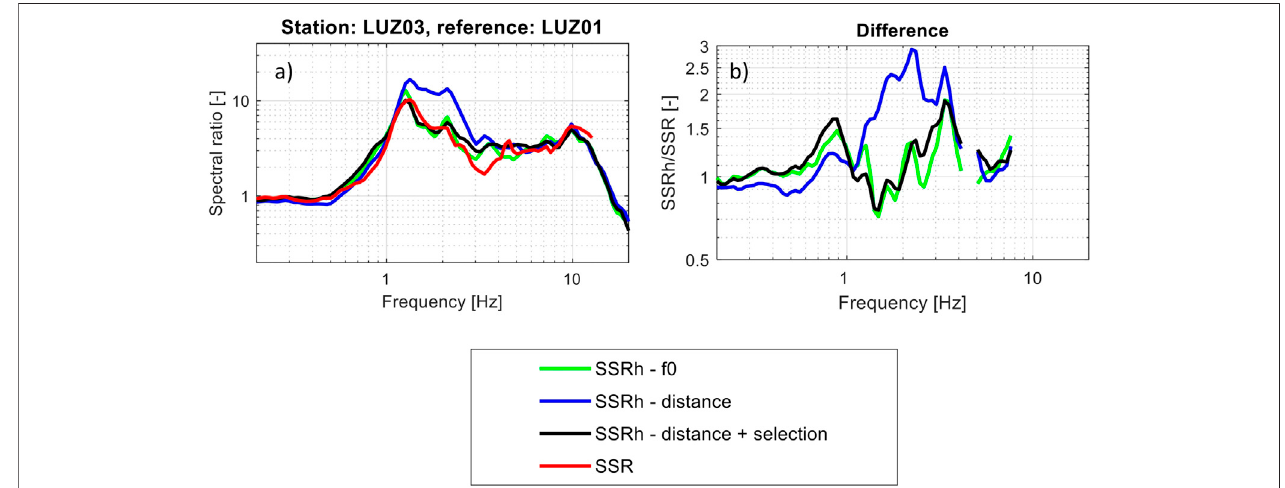
FIGURE10 |(A) Direct comparison ofSSR and SSRh forthe station LUZ03 calculatedusing differentstrategies considering the intermediate stations. (B) Relative difference between SSR and SSRh calculated using different strategies. More explanations in the text.